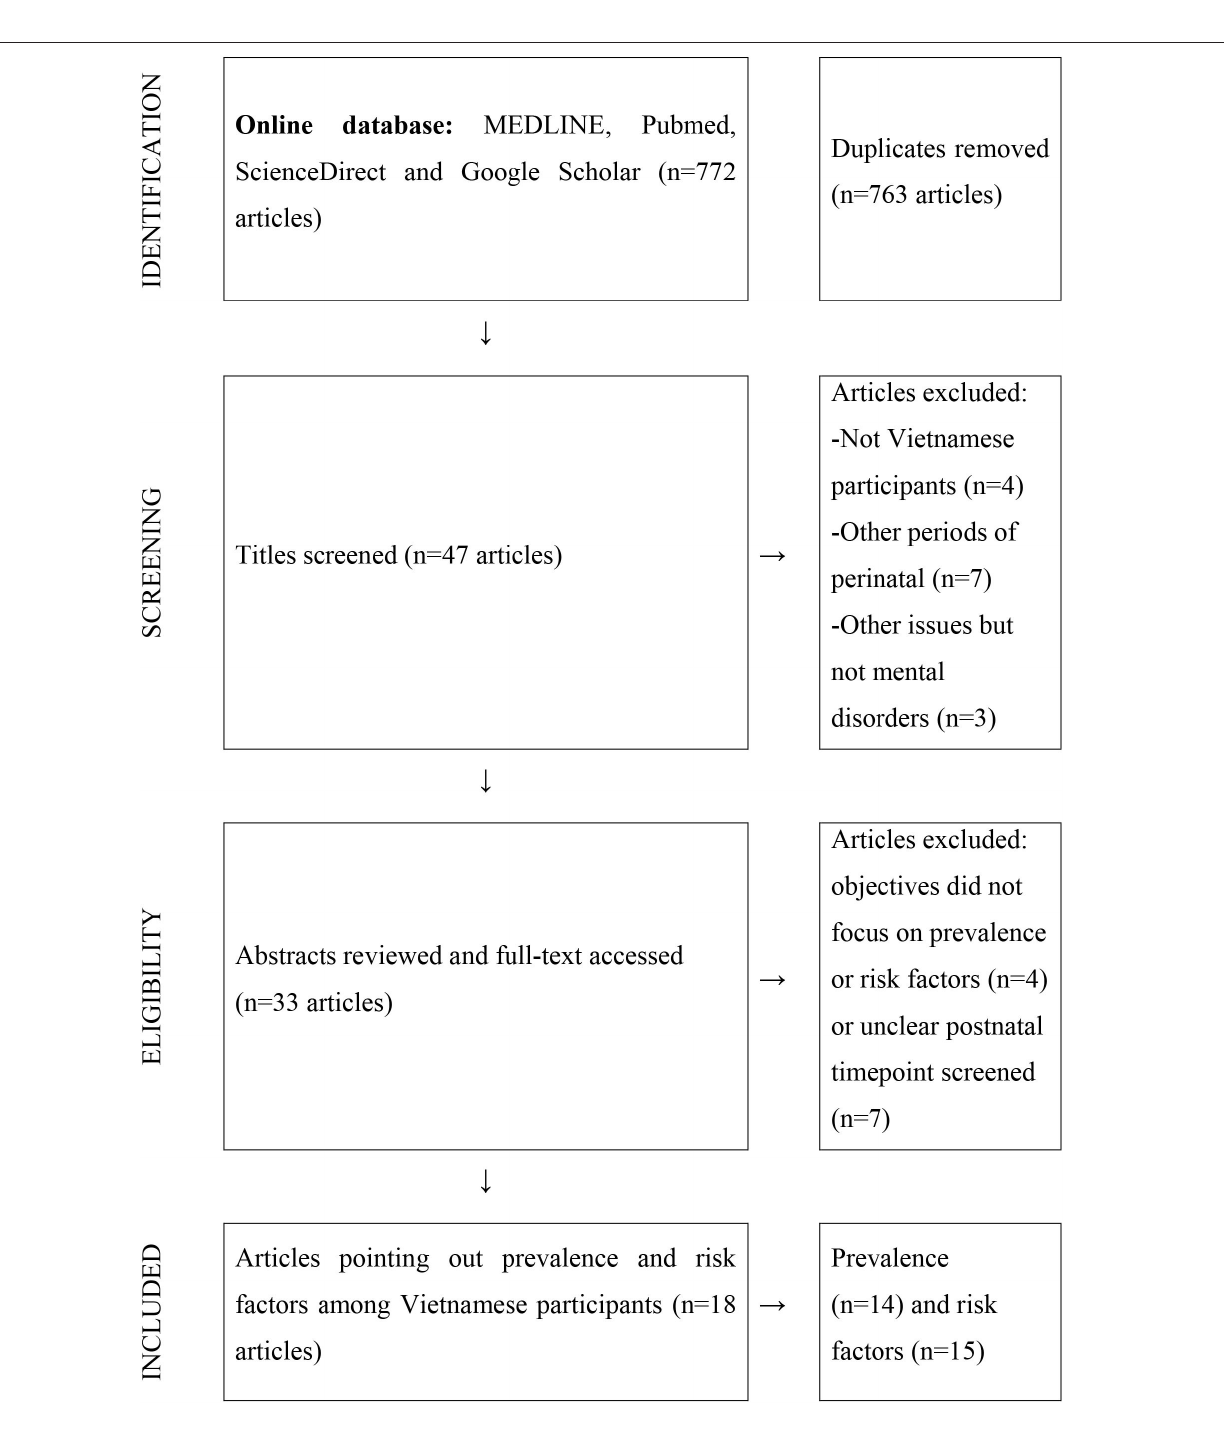
FIGURE 1 | PRISMA Flow diagram (Liao et al., 2019). Among articles that met the criteria to be chosen for review, 14 (77.78%) of them examined the prevalence of PPD with a clearly defined time point. Most studies used the EPDS measurement scale ( n = 9;